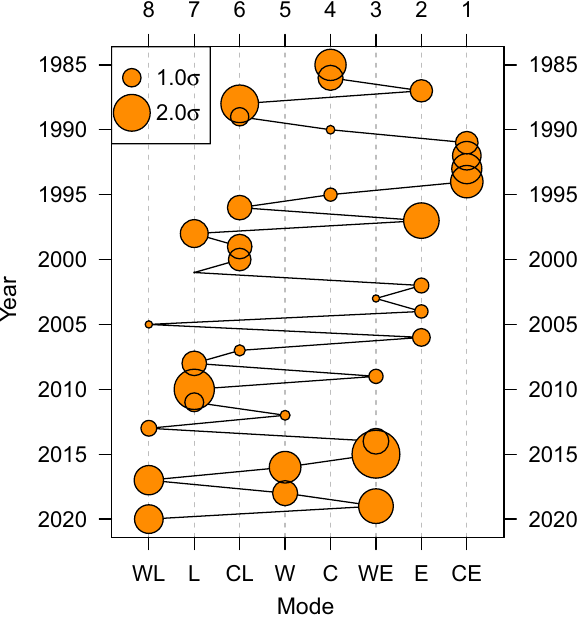
Figure 5. Chronology of the modes of environmental variability. For each year, the closest variability direction among the eight modes is shown with its magnitude. A smaller circle implies that the variability is less anomalous and closer to N. El Niño and La Niña trends repeat over time and tilt toward each warmer mode such as WE and WL. Considering the westernmost expansion of the atmospheric pattern in WL, a linear perspective suggests that every warmer La Niña environment could be one that people have scarcely experienced